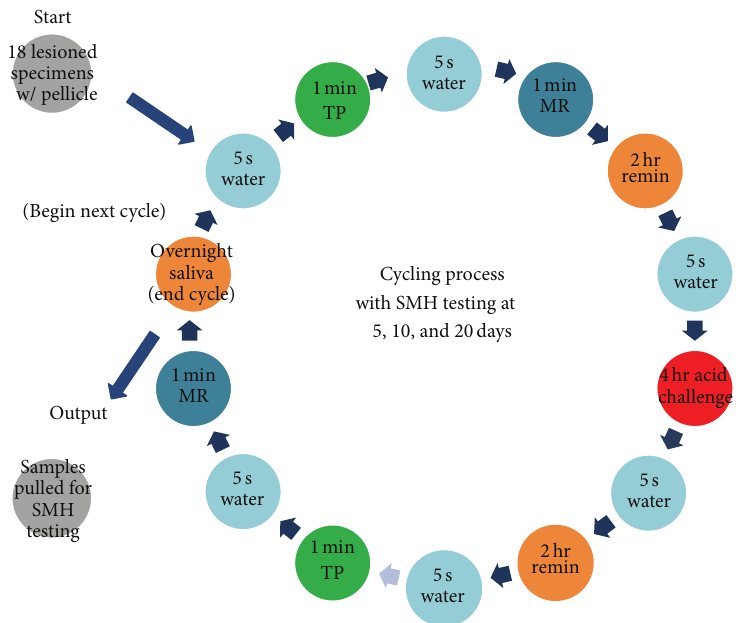
Figure 1: Daily treatment regimen for enamel substrates in the SMH study. TP: toothpaste. MR: